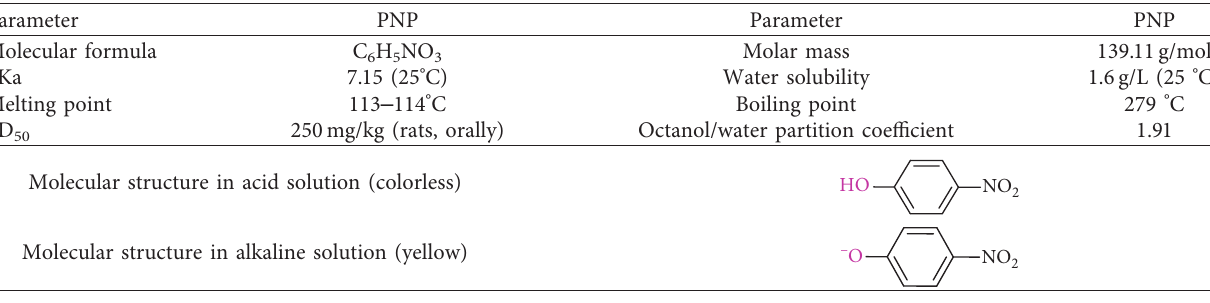
Figure 1: Significance of testing in the comigration of ENPs and environmental pollutants. Table 1: The physical and chemical properties of p -nitrophenol [32].